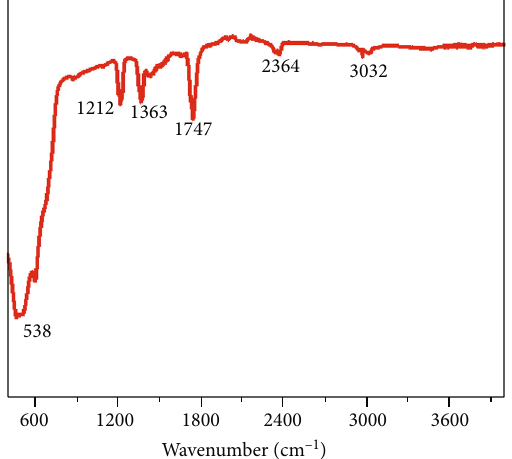
Figure 4: FTIR spectra of prepared CoF